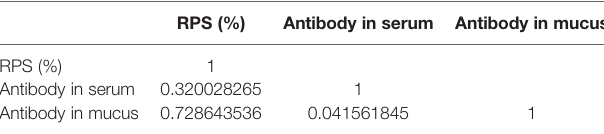
TABLE 5 | The Pearson correlation coef fi cient( r ) of RPS and antibody titer of immunized grouper with inactive V. harveyi vaccine. RPS (%) Antibody in serum Antibody in